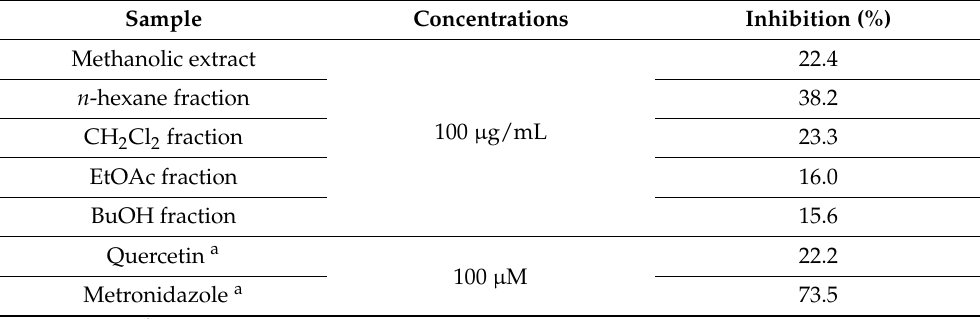
Table 1. Anti- H. pyroli activity of the MeOH extract and fractions derived from the solvent partitioning.